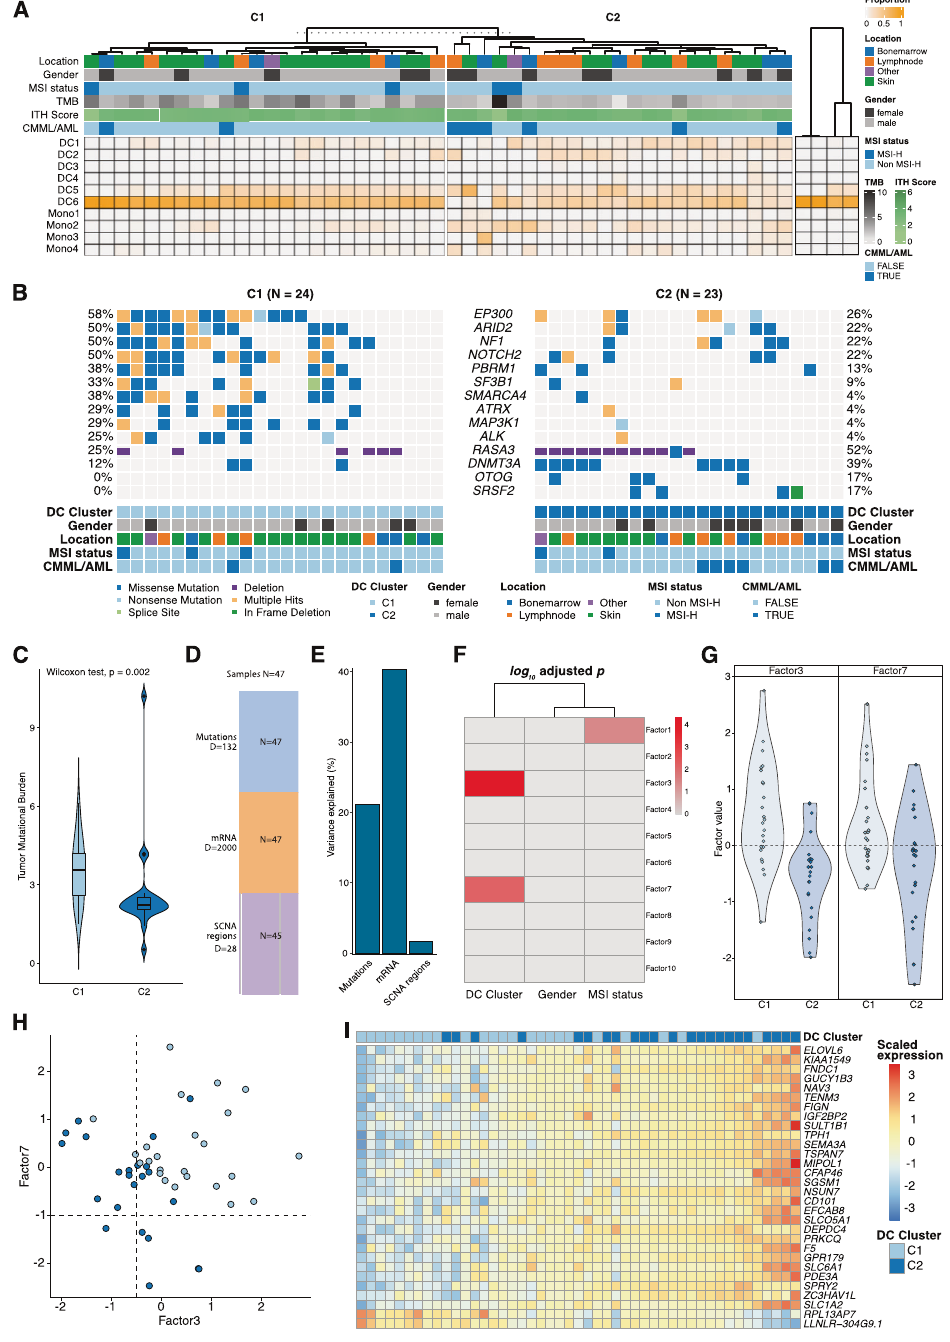
Fig. 2 Identi fi cation of pDC and cDC-derived subtypes. A Proportion of dendritic cells (DC1 – DC6) and monocytes (Mono1 – Mono4) according to the deconvolution analysis for BPDCN samples (left heatmap with annotations; TMB refers to tumor mutational burden and ITH score describes the inferred intra-tumor heterogeneity) and normal controls (peripheral blood pDCs; shown in the right heatmap without additional annotations). The optimal number of clusters was inferred using hierarchical clustering and average silhouette method. B Co- oncoplot of genes identi fi ed as signi fi cantly enriched between the two cluster (see Supplementary Fig. 10 for details). C Tumor mutational burden estimates for each cluster. D shows the number of samples ( “ N ” ) and features per feature group ( “ D ” ) used in the multi-Omics factor analysis (MOFA + ). E Variance explained per feature after training MOFA + (Mutations = SNVs and indels; mRNA = normalized expression values; SCNA region = genomic location of somatic copy number alterations). F Correlation of identi fi ed factors with selected covariates (only correlations where p adj < 0.05 are shown). G Beeswarm plots of latent Factor3 and Factor7 for each dendritic cell cluster. H Scatter plot of estimated factor values for each sample; light blue refers to C1 and dark blue to C2. I Scaled gene expression values of top genes ( n = 30) that correlated with Factor3; cluster annotation for each sample is shown above each